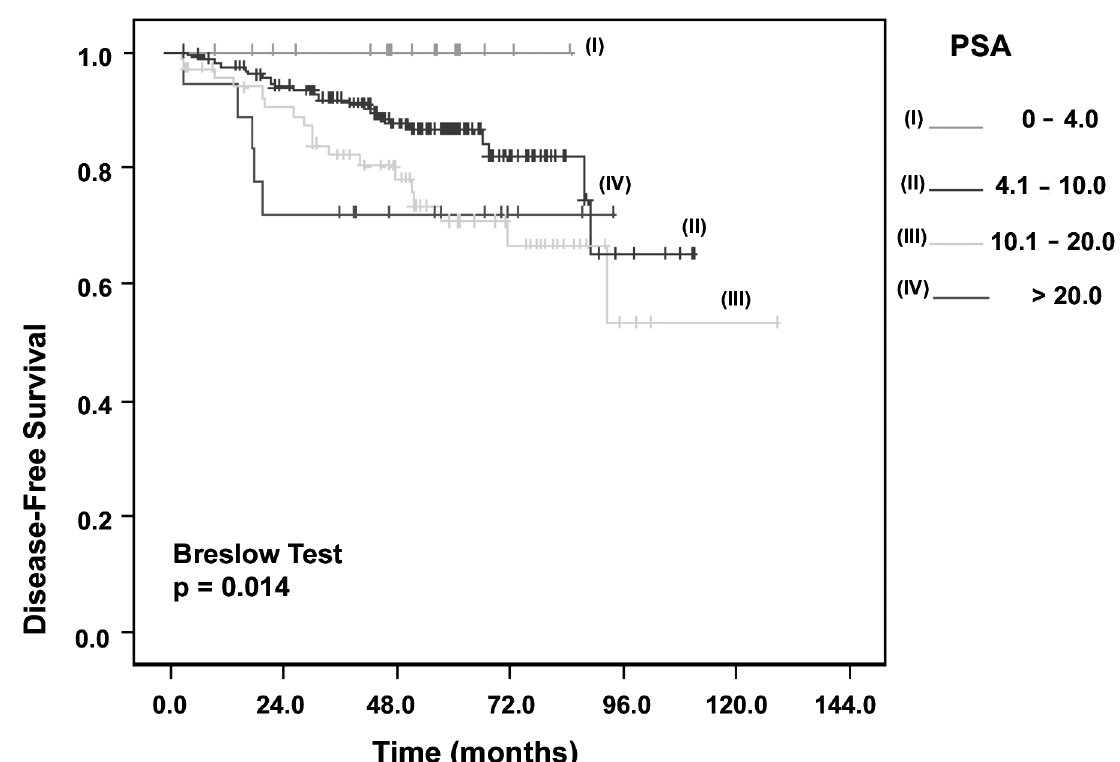
Figure 3 – Probability curve for recurrence-free survival according to PSA categories in patients with clinical stage T1c, and Gleason scores 2 - 8.